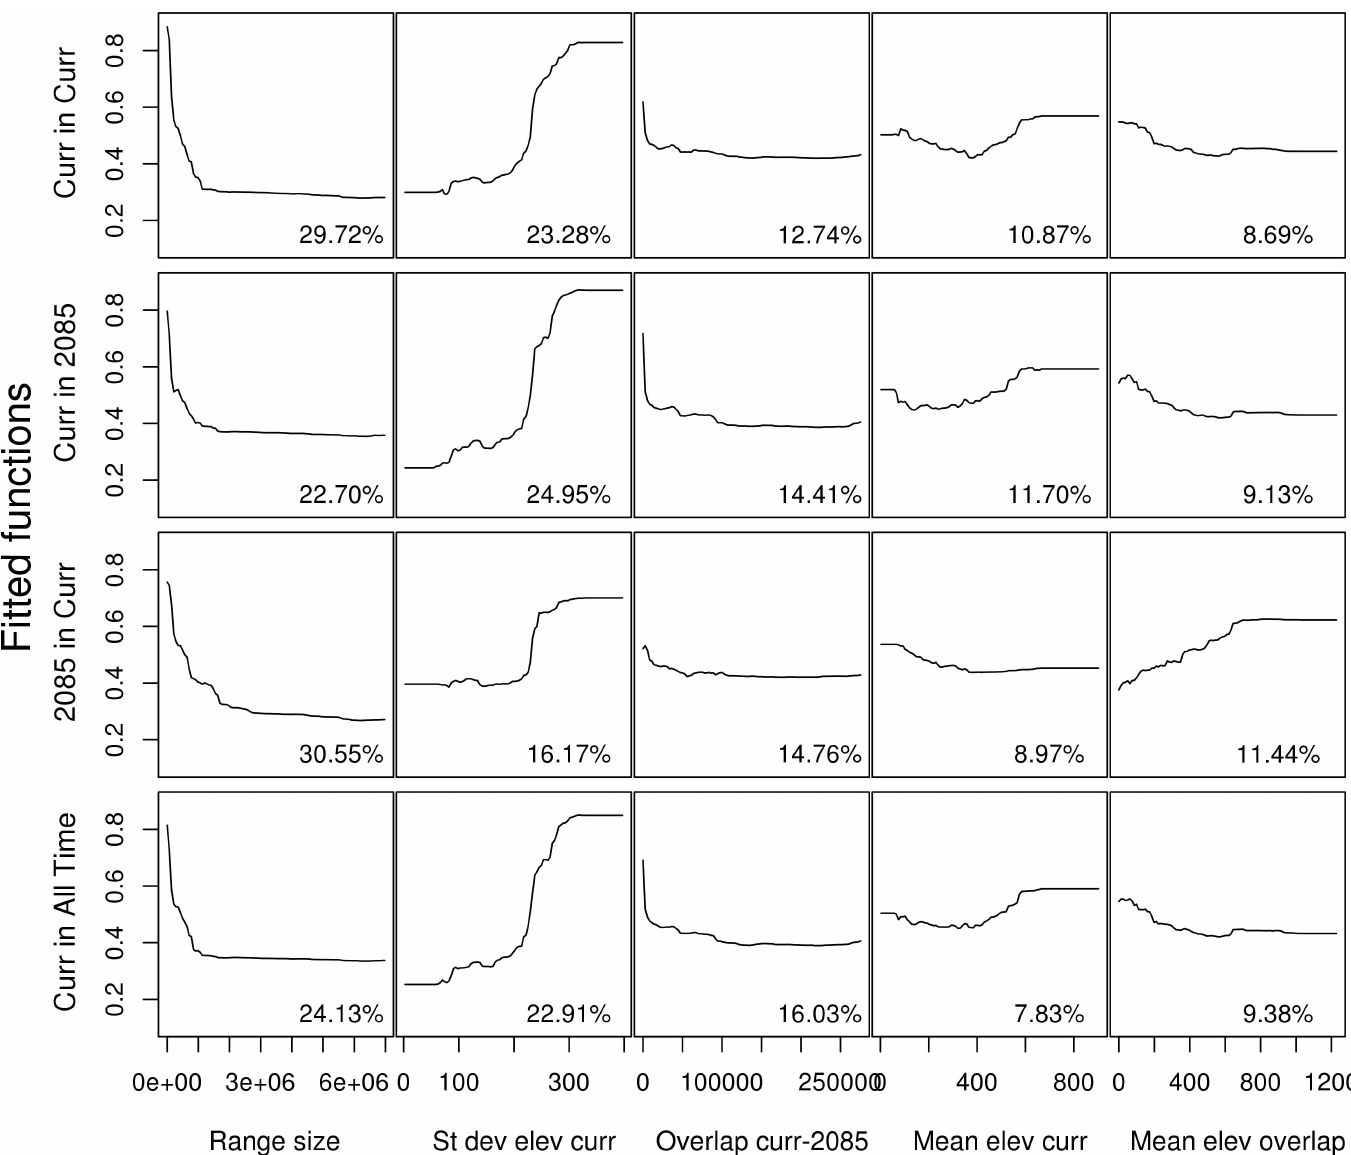
Fig 4. The boosted regression tree partial dependency plots. The plots demonstrate the influenceof the predictor variables(columns) on how well species were representedin the highestranking cells ( > top 25%) of each of the solutions.Rows: 1) proportionof species current distribution captured in the